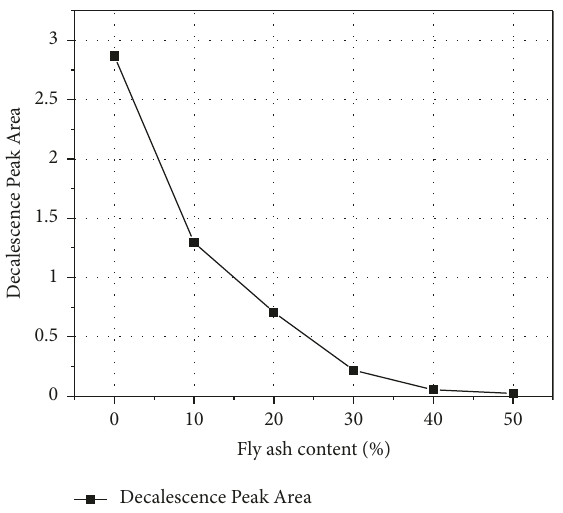
Figure 6: Change tendency of Ca(OH) 2 decalescence peak Table 4: Area of Ca(OH) 2 decalescence peak.